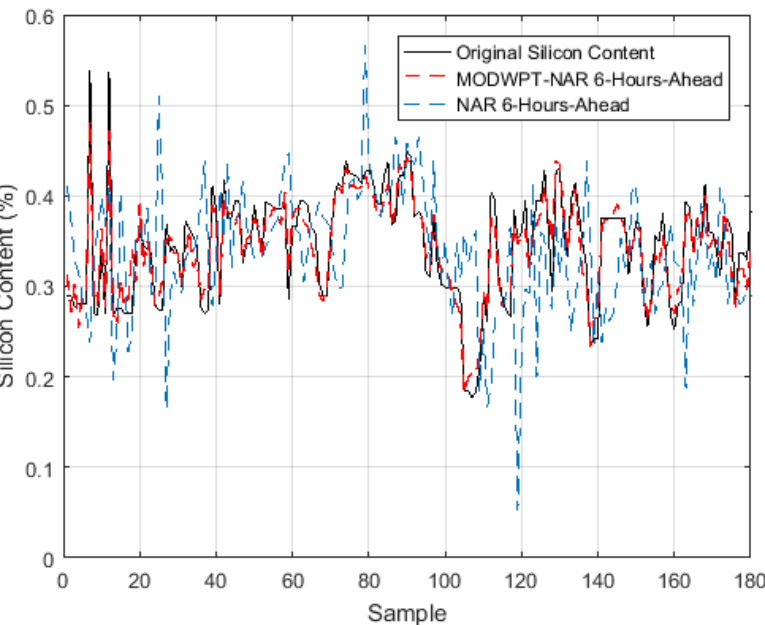
Figure 7. Silicon content and its six-hour-ahead forecasts from the NAR and MODWT-NAR